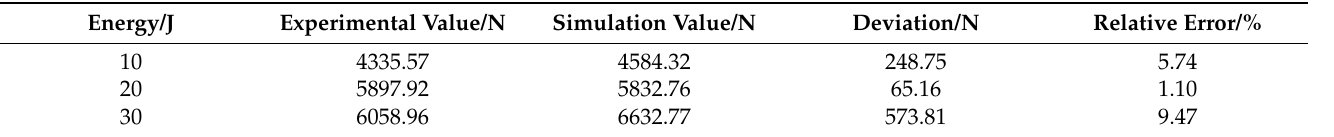
Figure 6. Comparison of simulation and experiment contact force histories under different impact energies: ( a ) 10 J, ( b ) 20 J and ( c ) 30 J. Table 3. Comparison of peak contact force in experiment and simulation under different impact energies.